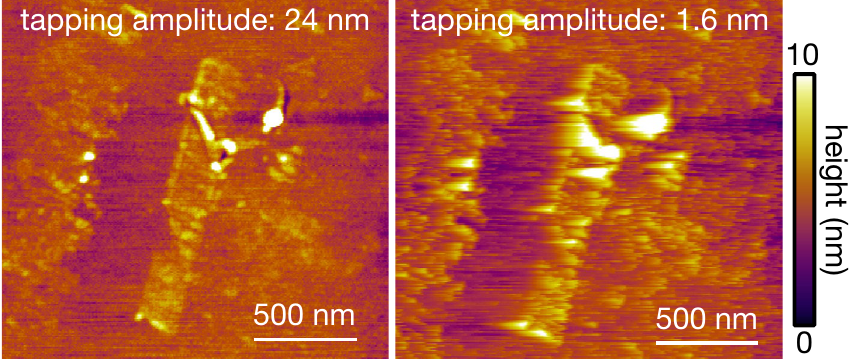
Figure 6. AFM images of WS 2 acquired at tapping amplitudes of 24 and 1.6